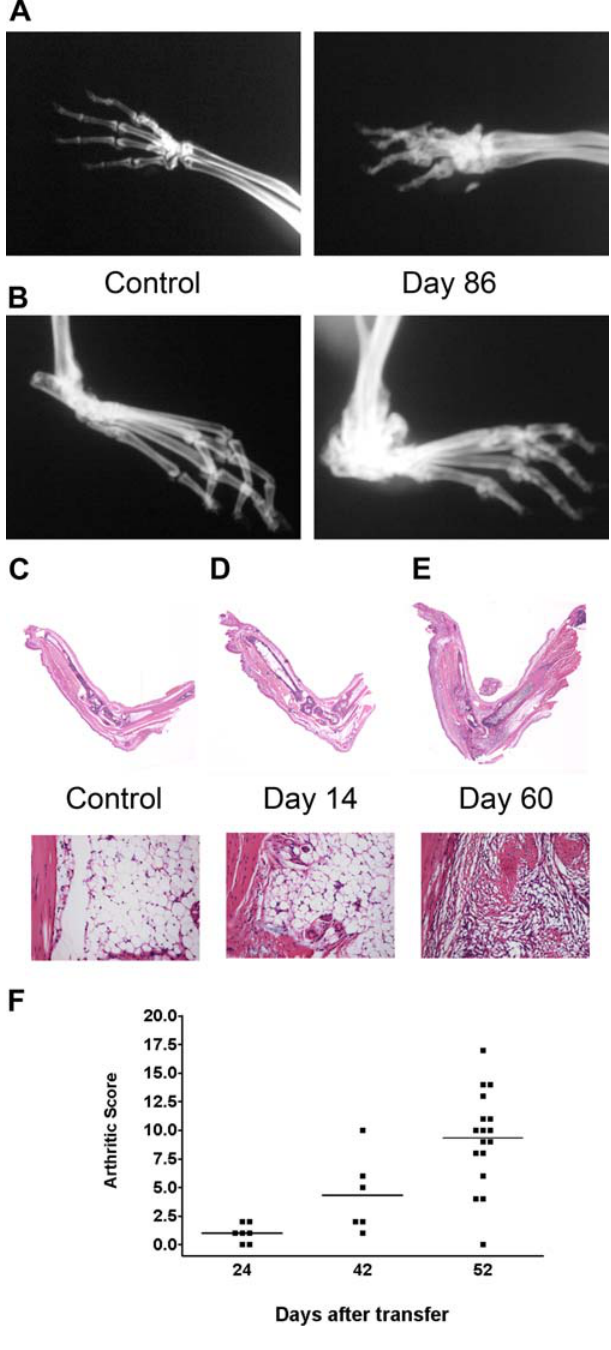
Figure 2. Adoptively Transferred T Cells Induce Arthritic Pathology in Recipient Mice (A) X-ray radiographs of fore limbs and (B) and hind limbs comparing mPCC,CD3 e (cid:1) / (cid:1) mice without a T cell transfer (left panels) and one 86 d after (right panels). (C–E) Hindlimbs from mPCC,CD3 e (cid:1) / (cid:1) mice were sectioned and stained by HEMATOXYLIN AND EOSIN before (C) T cell transfer and 14 d (D) or 60 d (E) afterward. Lower panels show magnification of the joint regions from the top panels, to illustrate cellular infiltrates in the tibiotarsal region. (F) Clinical scores quantitate increased limb pathology in transfer recipients on a scale of 0 to 56. Bars represent arithmetic means in each group. DOI: 10.1371/journal.pbio.0040340.g002